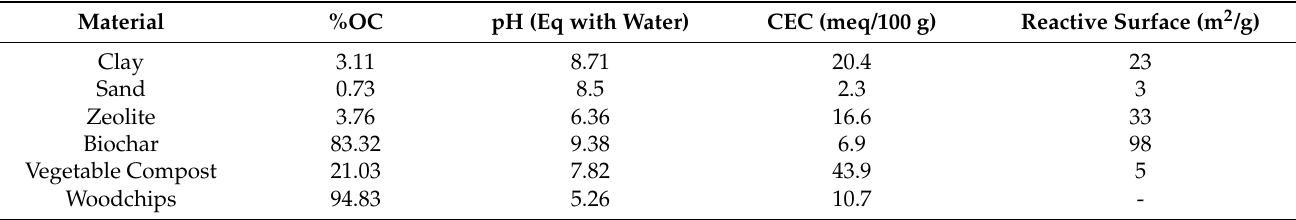
Table 1. Physicochemical properties of the tested